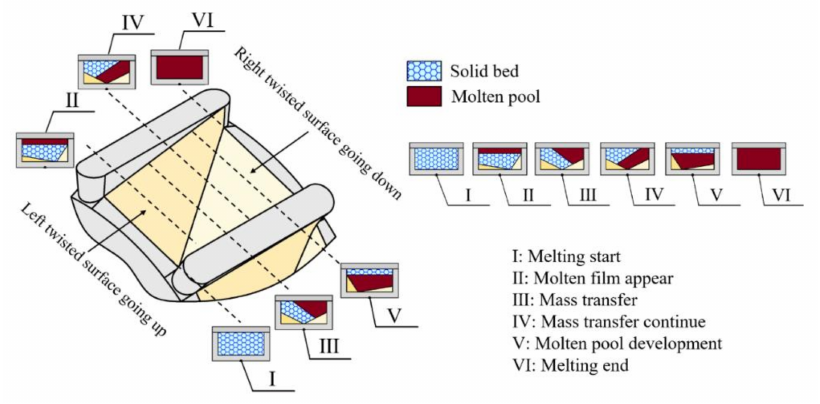
Figure 9. The molten and mass transfer mechanism model in one torsion channel.